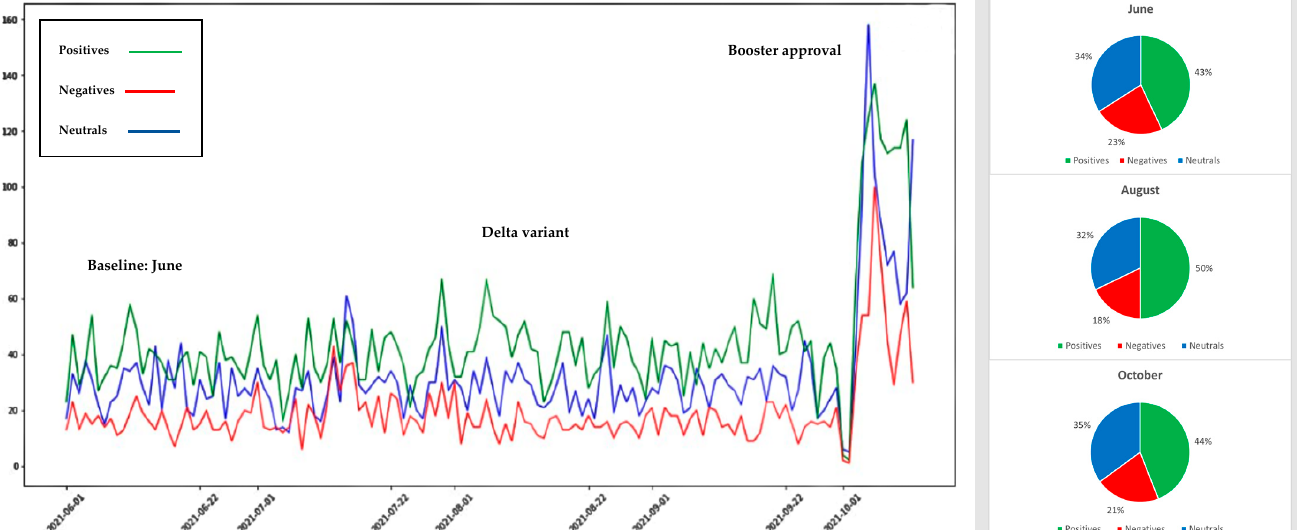
Figure 4. Sentiment analysis results of tweets related to Pfizer vaccine.